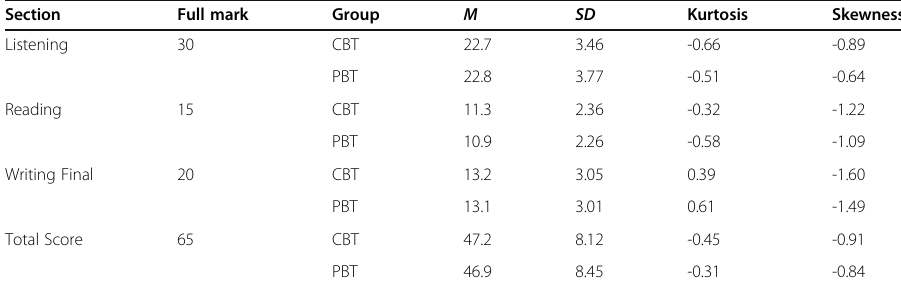
Table 8 Descriptive statistics by sections on CBT and PBT (NCBT = 46, NPBT =